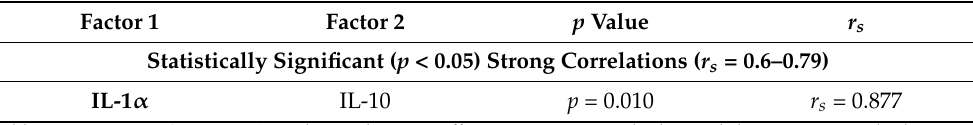
Table 5. An overview of the Spearman’s rank correlation analysis, conducted to identify the moderate and strong links between the number of positive factors in the second-time surgery CLP group.